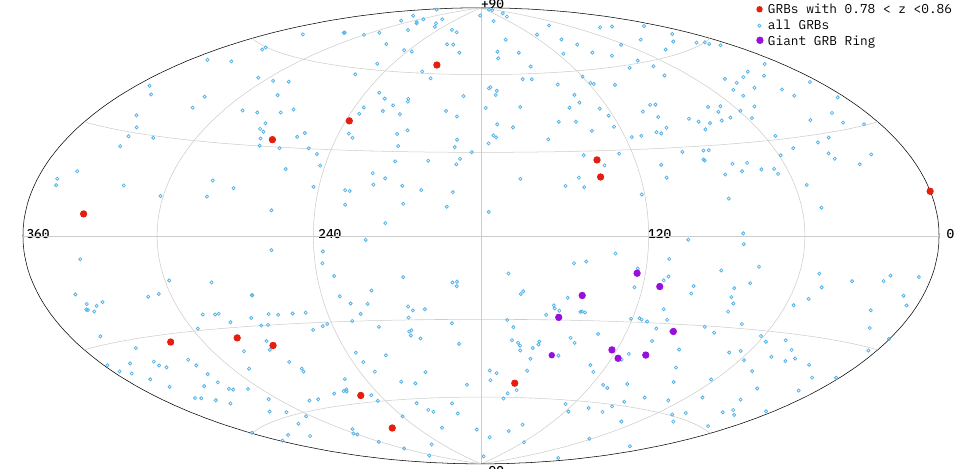
Figure 4. The Giant GRB Ring’s 0.78 < z < 0.86 redshift range in the current data. The ring-like structure of objects is in the lower right part of the frames, highlighted in violet